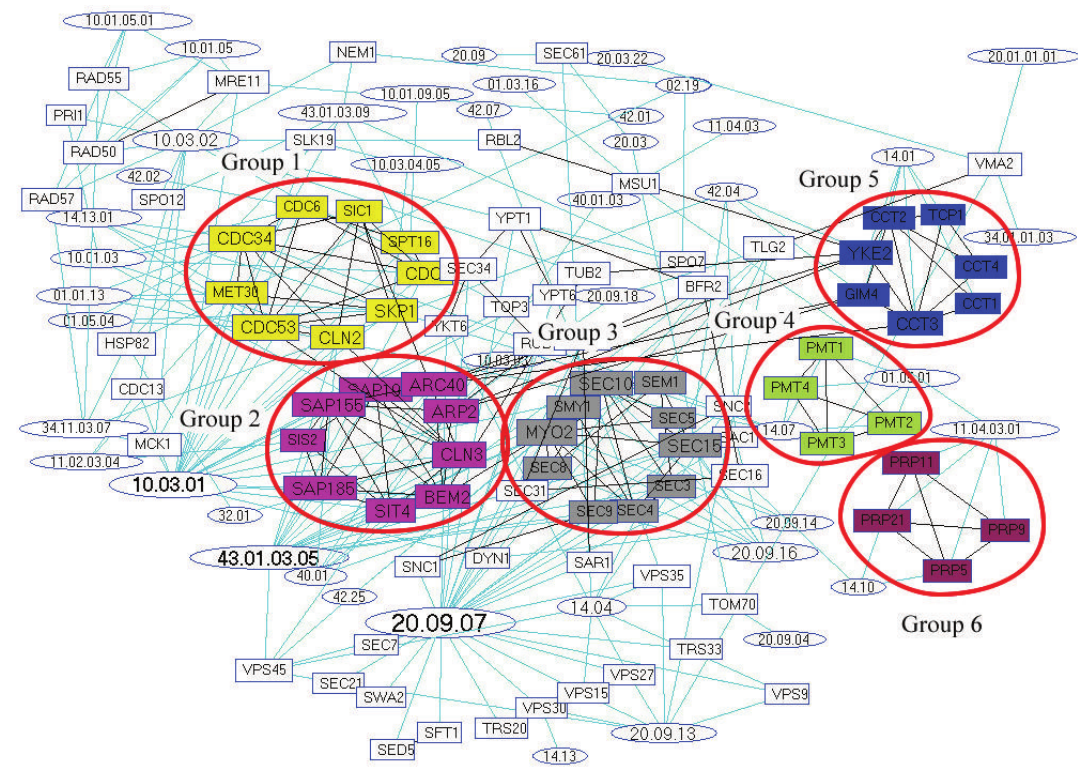
Figure 3: Six near-cliques found in yeast protein interaction networks. Proteins in each near-clique share at least one function with other proteins within the